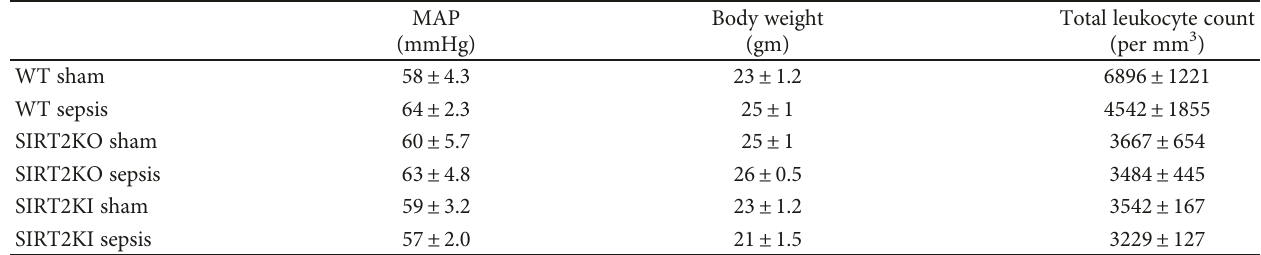
Table 1: Mean arterial blood pressure (MAP) and body weight in di ff erent groups of mice: the MAP, body weight, and total leukocyte count of di ff erent groups (mean ± sem; n = 5 per group) of mice studied did not show a signi fi cant di ff erence from each other using Tukey ’ s post hoc